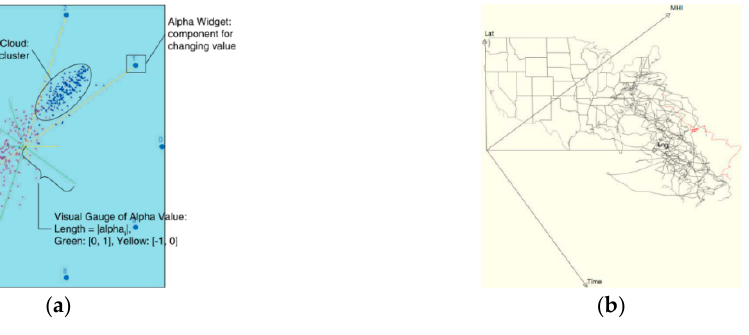
Figure 39. Enhanced star-map visualization: ( a ) star-coordinate system implementation with the VISTA model [103]; and ( b ) StretchPlot abstracts the trajectories from geospatial movements into abstractive movements of demographic and social variables [102].